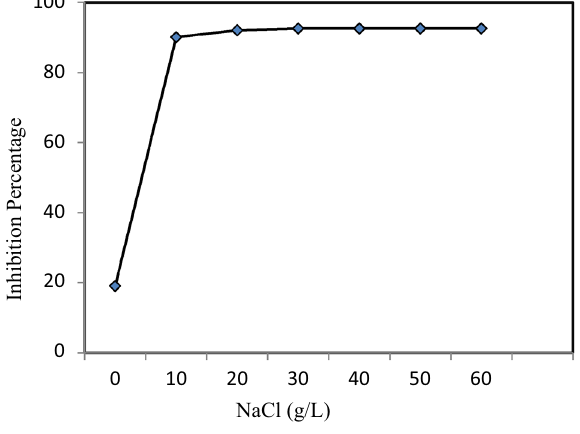
Table 2. The nature of flocculation behavior of copolymers reduces the scale inhibition efficiency (Shakkthivel and Vasudevan 2007) (Table 3).